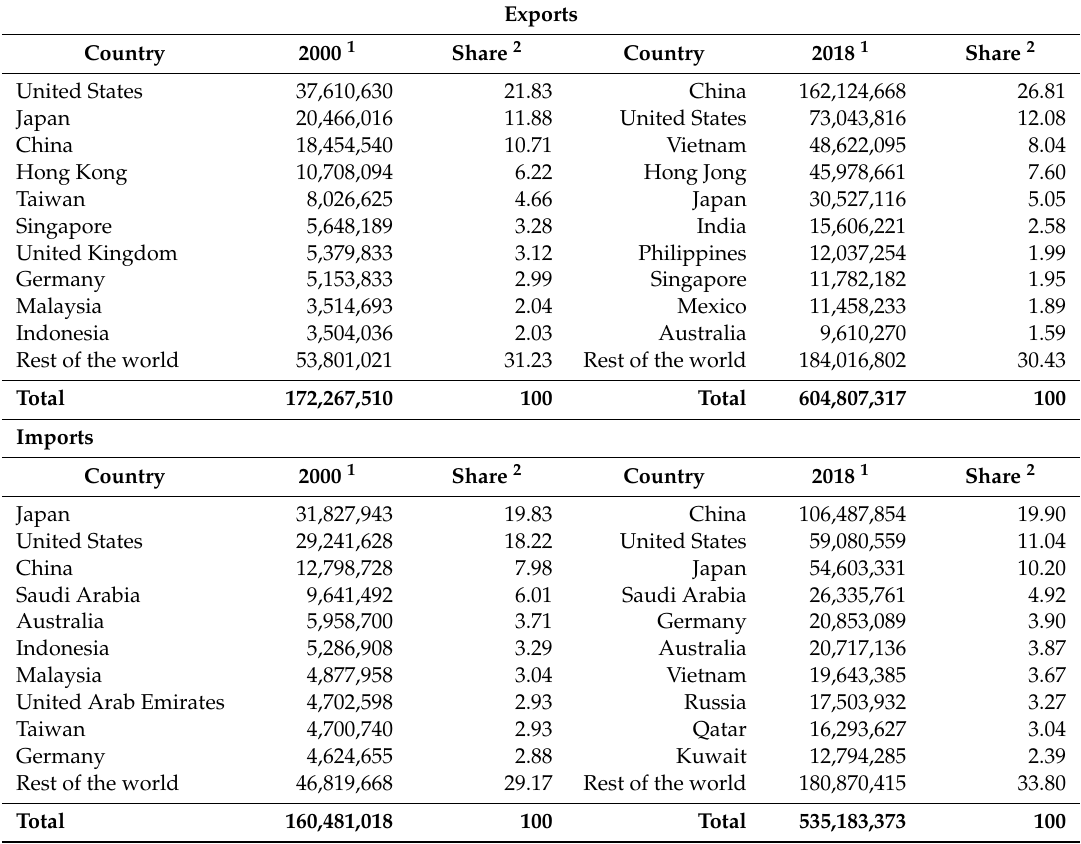
Table 2. Exports and Imports by Country: South Korea